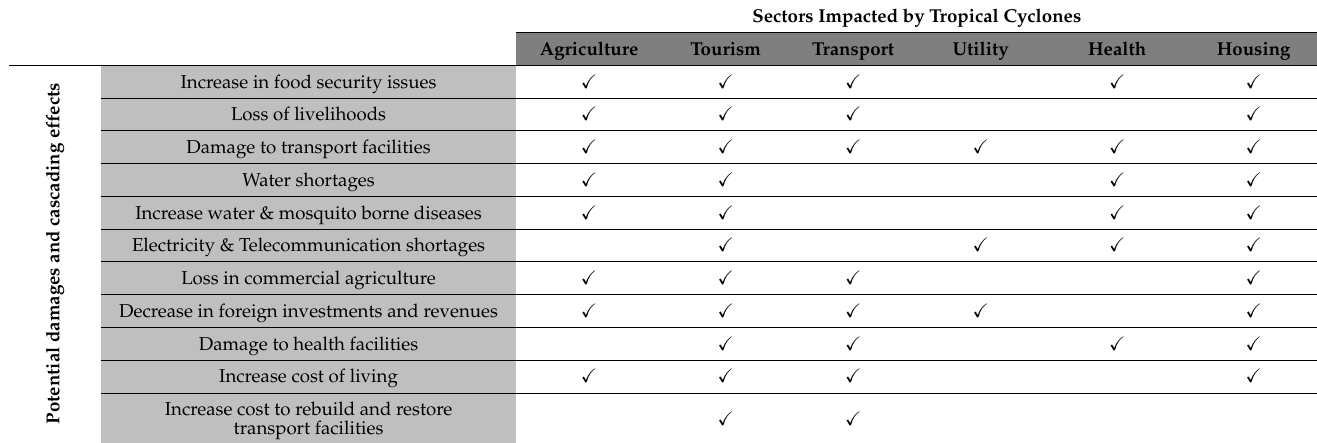
Table 2. Link between the sectors and the damages and cascading effects caused by TC. Sectors Impacted by Tropical Cyclones Agriculture Tourism Transport Utility Health